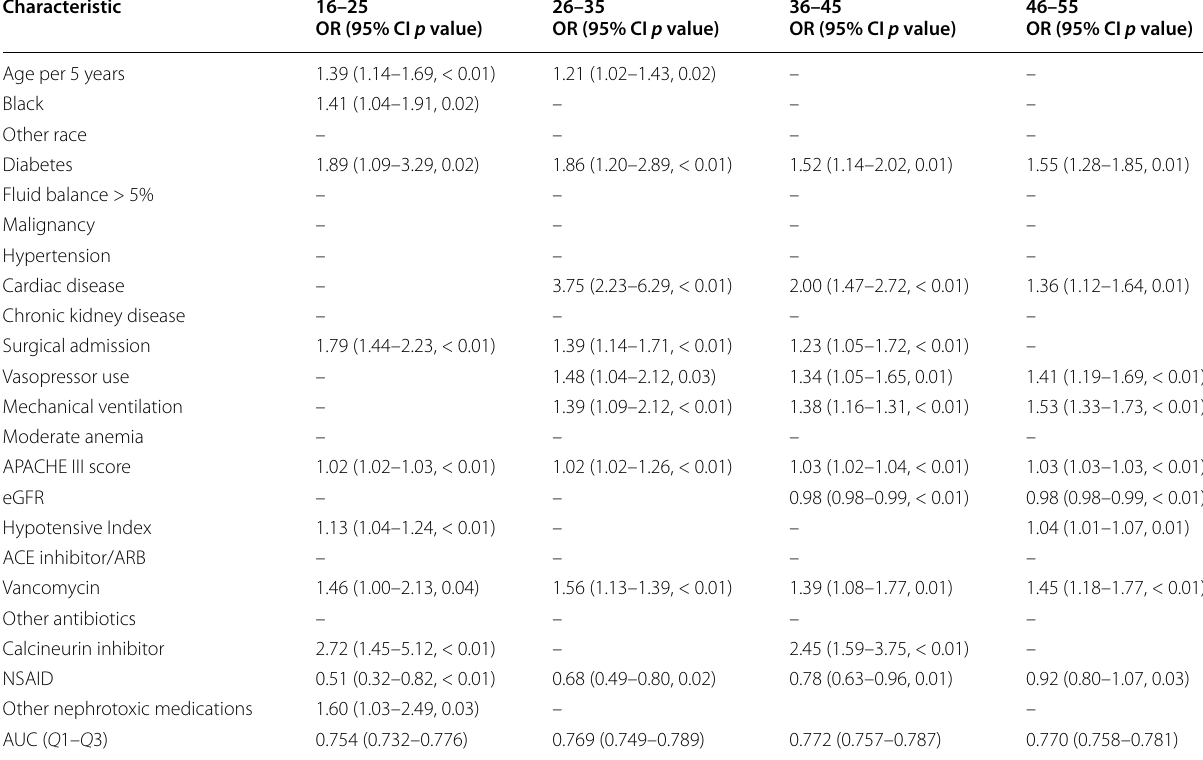
Table 2 Multivariable logistic regression of risk factors for individuals with acute kidney injury compared to those with- out acute kidney injury by age categories